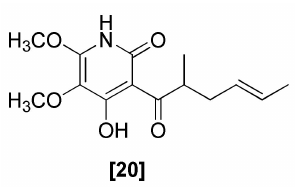
Figure 5. Structure of antifungal pyridone [20] harzianopyridone from T. harzianum